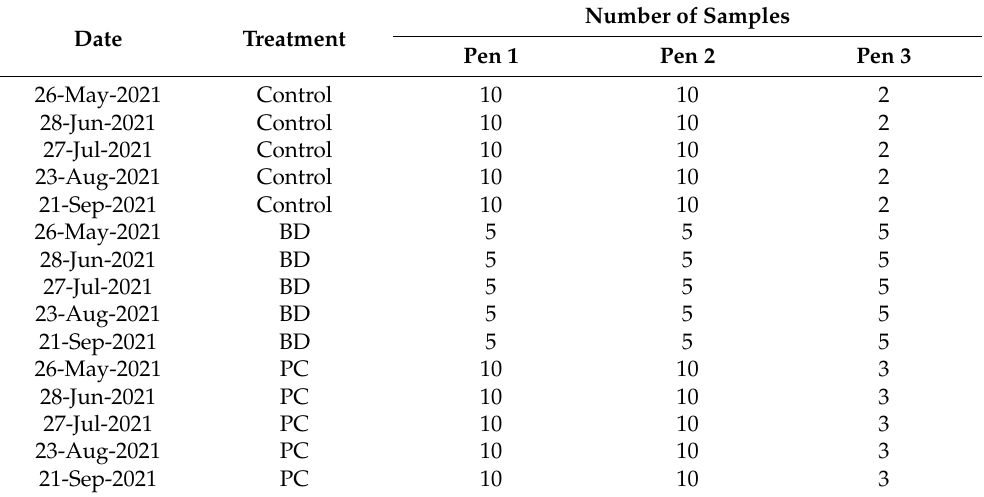
Table 1. Overview of the fecal sampling design with corresponding sample